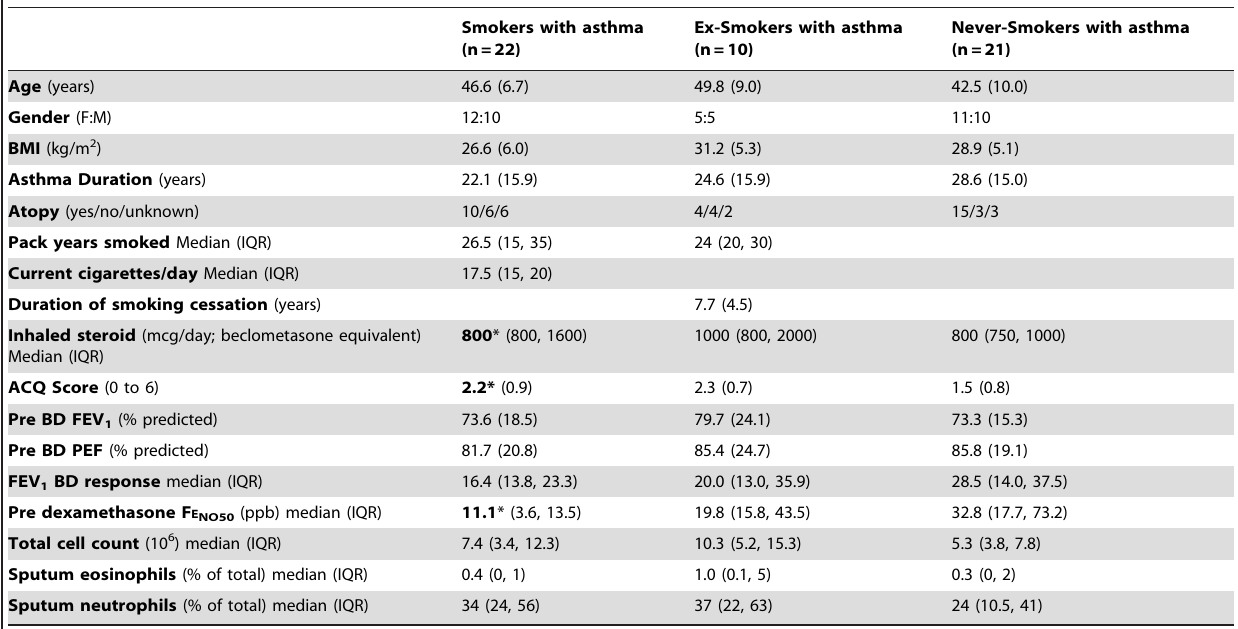
Table 1. Baseline demographics of participants (n=53).